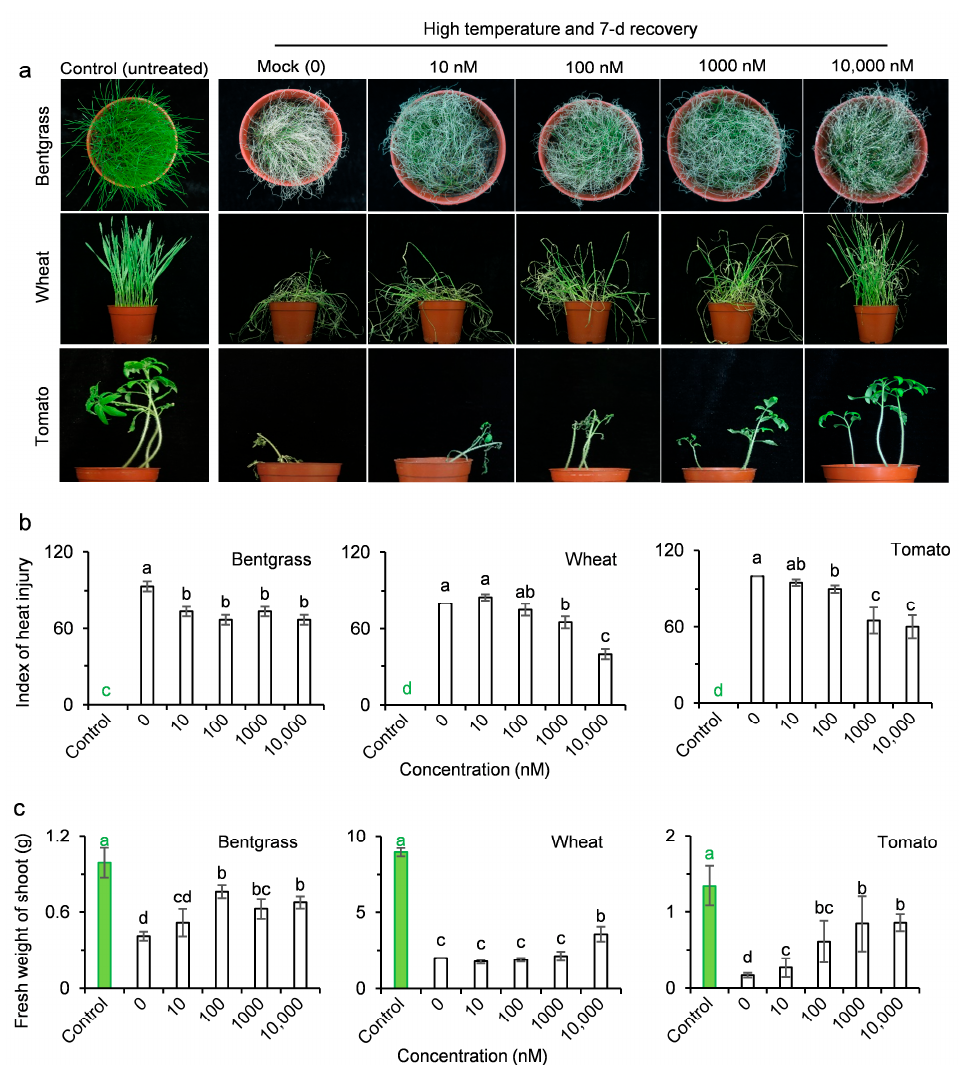
Figure 5. Induction of resistance to high temperature by AMHA in plant seedlings of three crops. After pretreatment with a water dilution of Tween-20 at 0.02% (mock) or different concentrations of AMHA containing 0.02% Tween-20 (10, 100, 1000 and 10,000 nM), seedlings were incubated for 9 h at 45 ◦ C (bentgrass and wheat) or 42 ◦ C (tomato) under 200 µ mol m − 2 s − 1 light and recovered at normal temperature for 7 d. Seedlings without any treatment, kept in normal growth condition, were used as untreated controls. ( a ) Phenotypes of plants after high temperature treatment. Photographs were taken after recovery for 7 d. ( b ) Effect of AMHA pretreatment on the heat injury index of three plant species treated with high temperature. ( c ) Effect of AMHA pretreatment on the shoot fresh weight of three plant species treated with high temperature. Values are the means ± SD of four independent biological replicates. Different small letters above error bars indicate significance at 0.05 level.